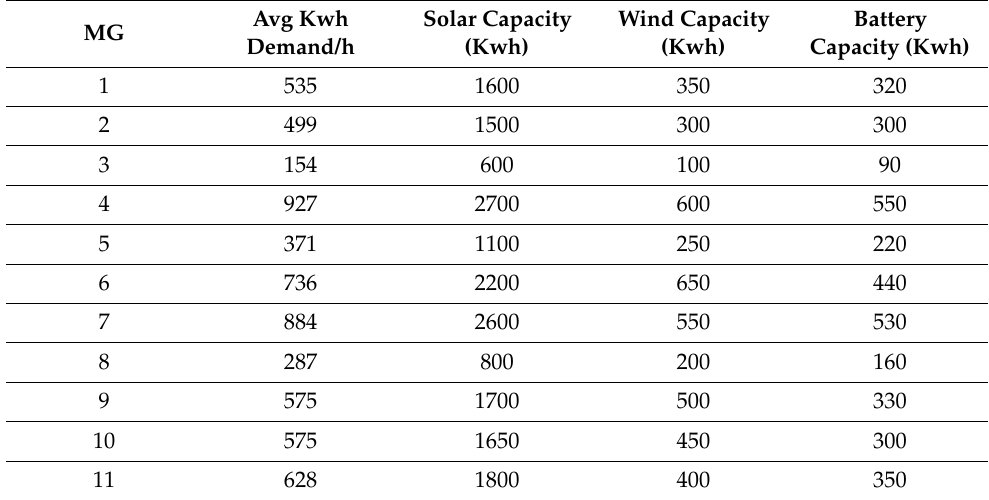
Table 4. Electricity demand and electricity production capacity of the renewable energy source and battery storage capacity at each microgrid. Avg Kwh MG